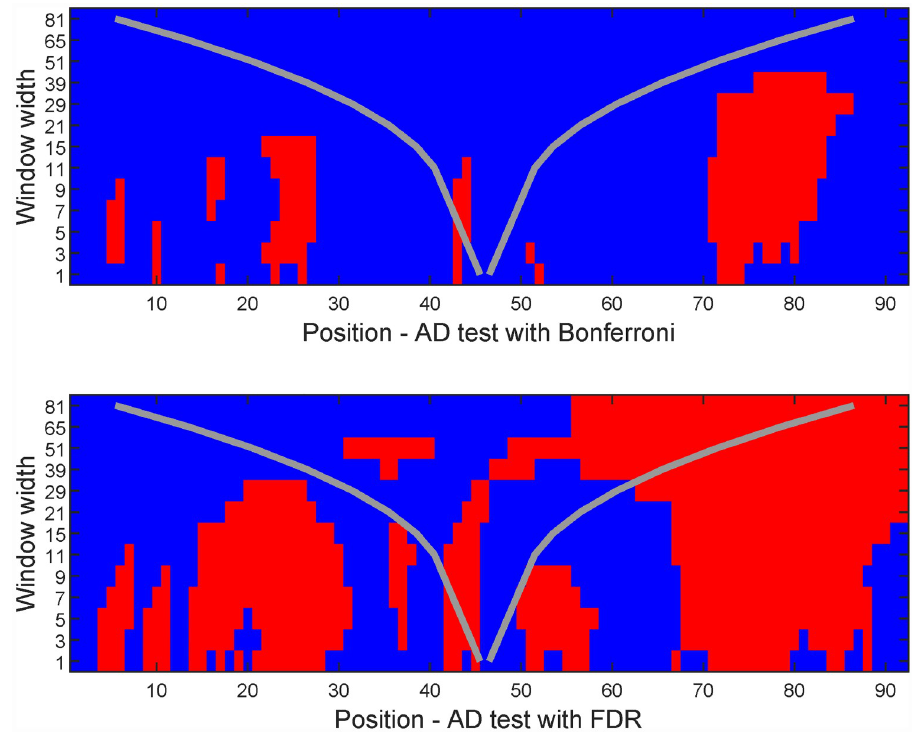
Fig 8. Significance maps for summer temperatures in Oslo. See Fig 3 for annotation